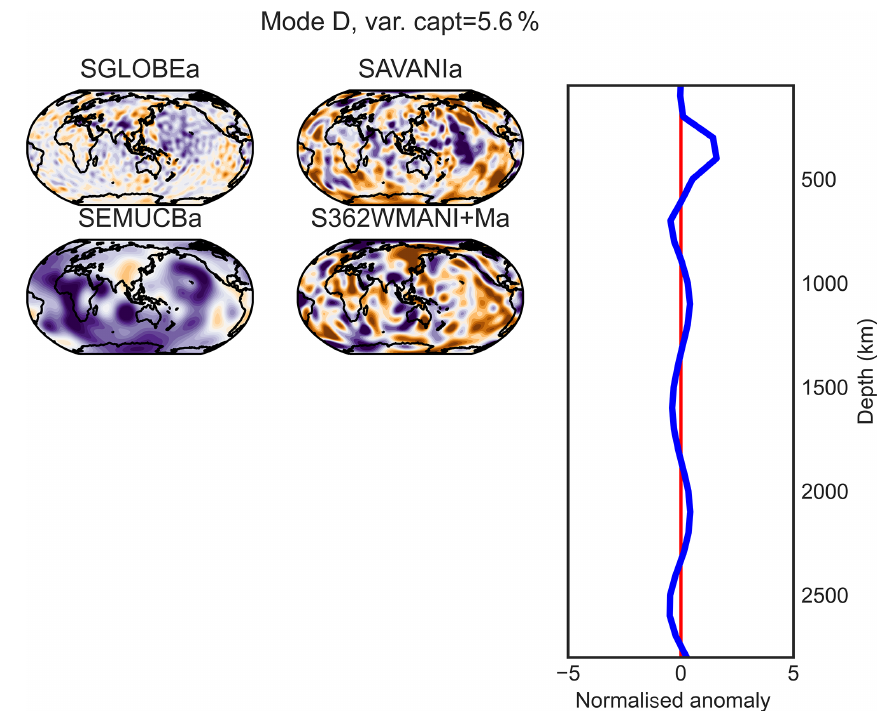
Figure E4. PC D (maximum at 400km of depth) of the combined analysis of the anisotropic parts of the models.